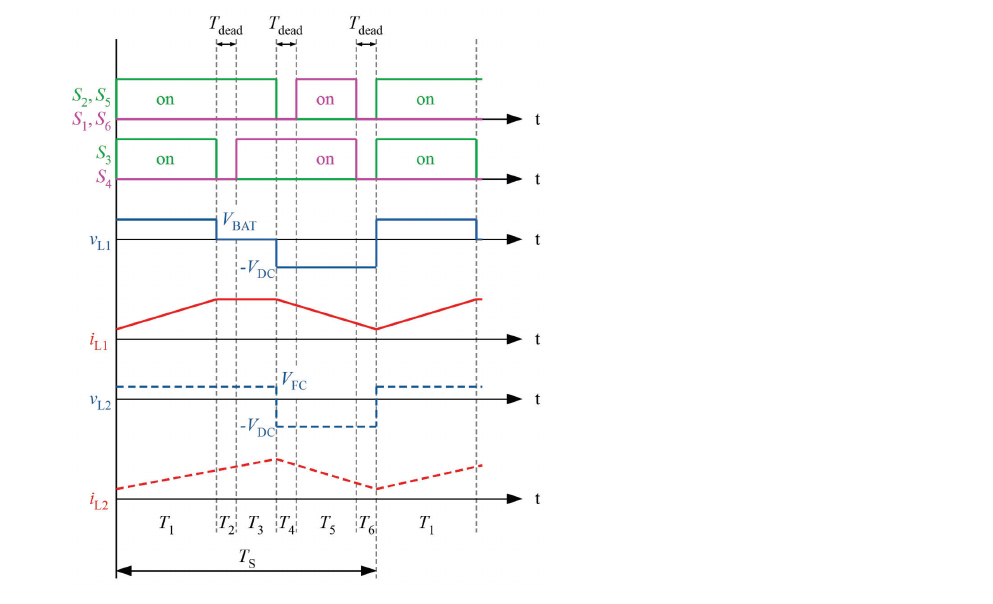
Figure 16. Active switch states, inductor voltages and inductor currents for BFC2DC mode during time intervals T 1 – T 6 .